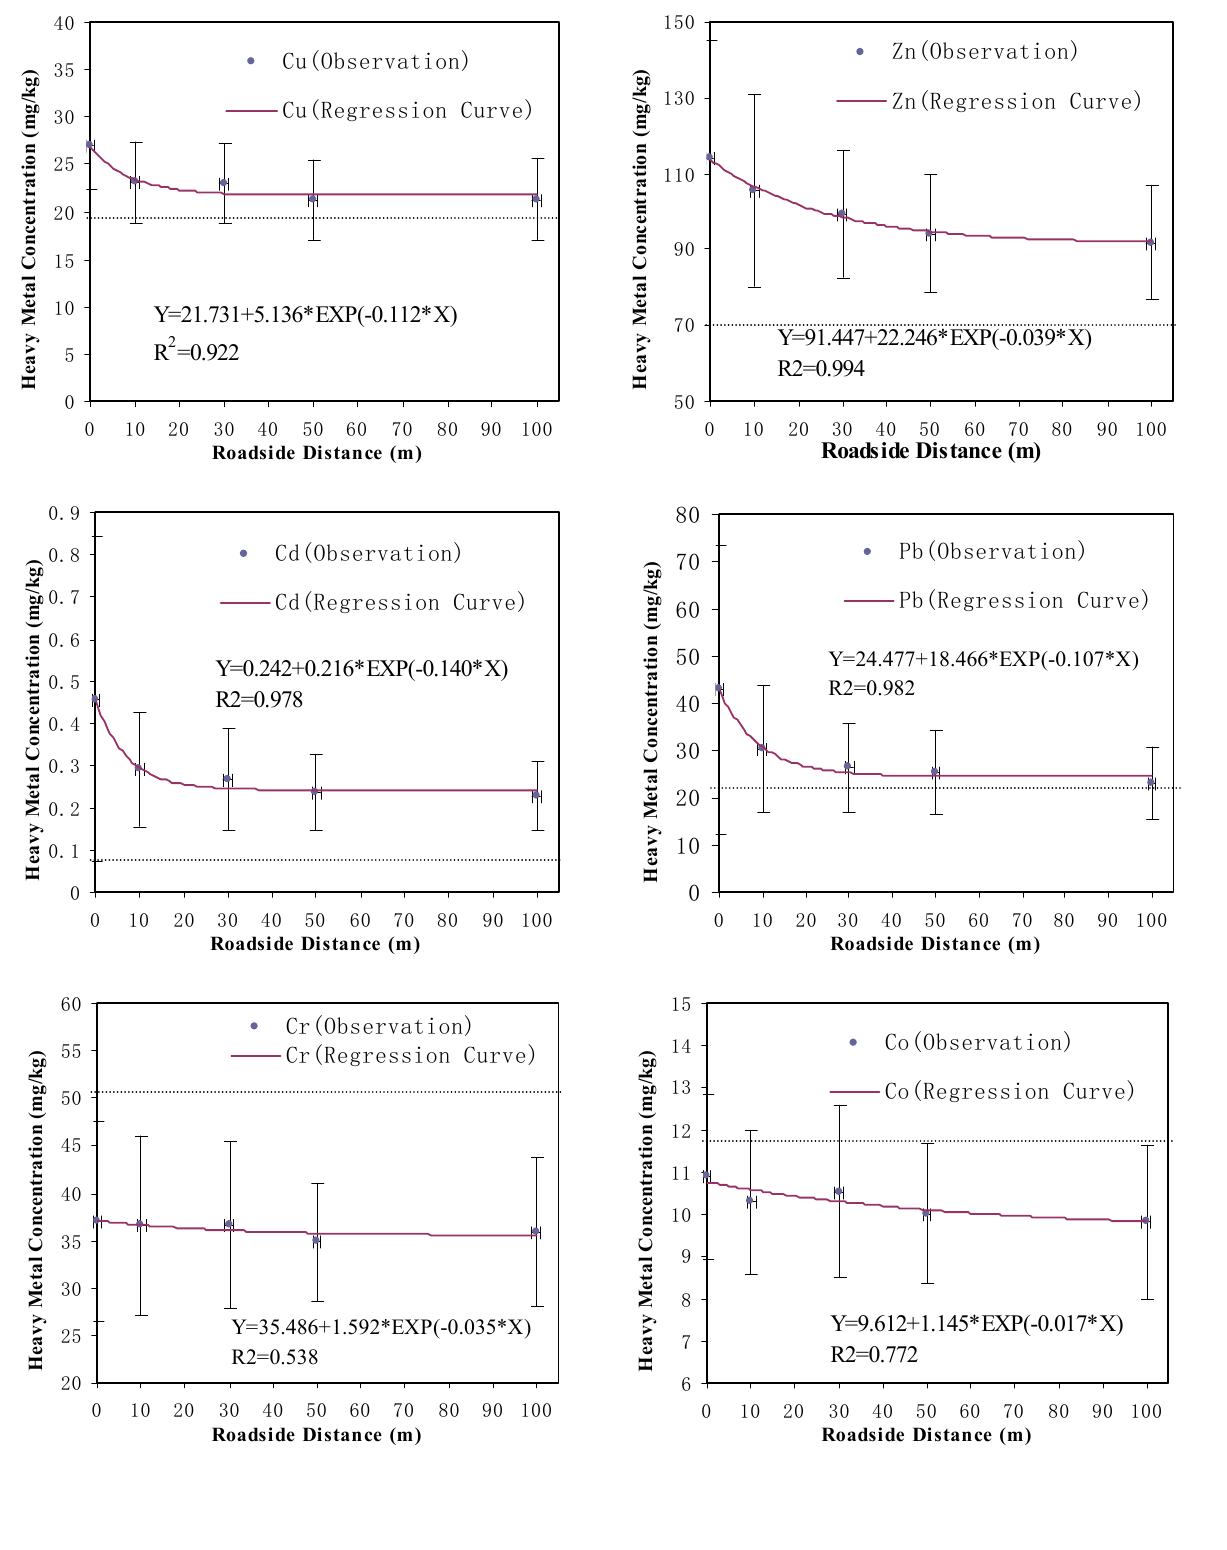
Figure 2. Observations and regression curves of heavy metals concentrations (mg·kg − 1 ) in roadside soils (the dash lines represent background